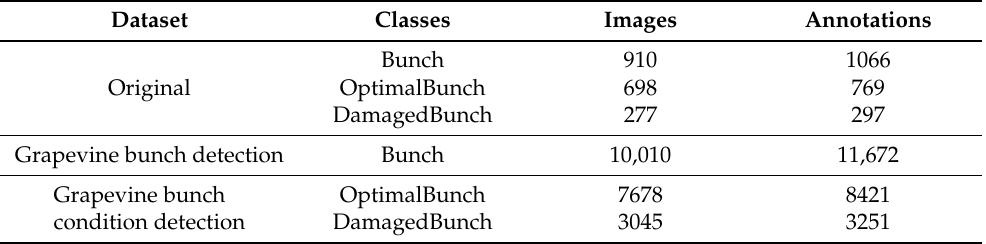
Table 4. Number of images and annotated objects per class after and before augmentation.